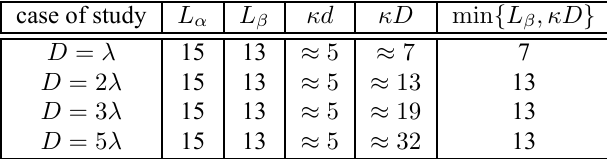
Table 1: Parameters L α (for α = 5 ), L β (for β = 6 ), κd and κD for all the cases of